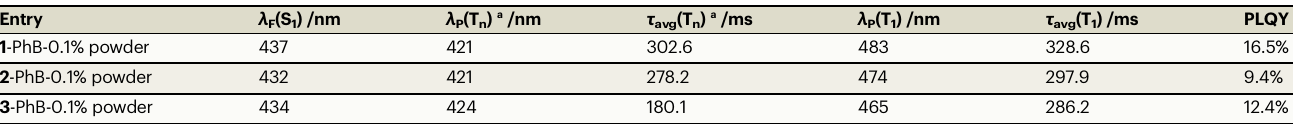
Fig. 3 | Photophysical properties of compound 3 system. a Molecular structure of compound 3 , steady-state and delayed emission spectra (1ms delay) of 3 -PhB- 0.1%powderatroomtemperature,and fl uorescenceandafterglowphotographsof 3 -PhB-0.1% powder at room temperature; b Temperature-dependent delayed emission spectra (1ms delay) of 3 -PhB-0.1% powder from 77K to 300K; c Excited stateenergylevelsattheoptimizedgeometryofT 1 ,T 2 andT 3 statesofcompound 3 ,